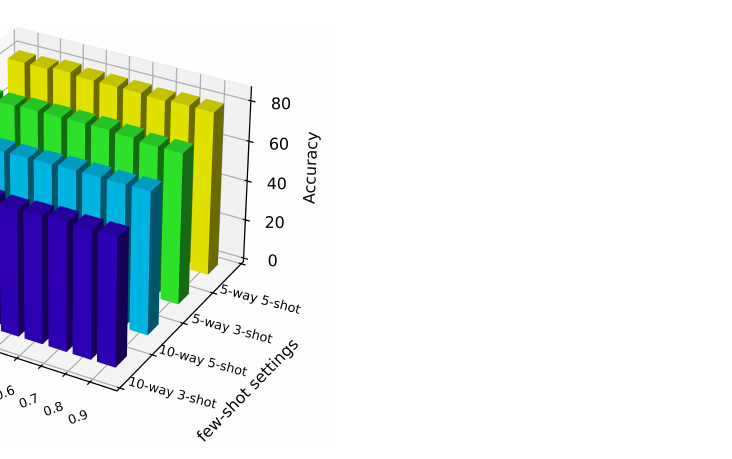
Figure 2. Node classification results based on choosing the balancing parameter λ on DBLP.